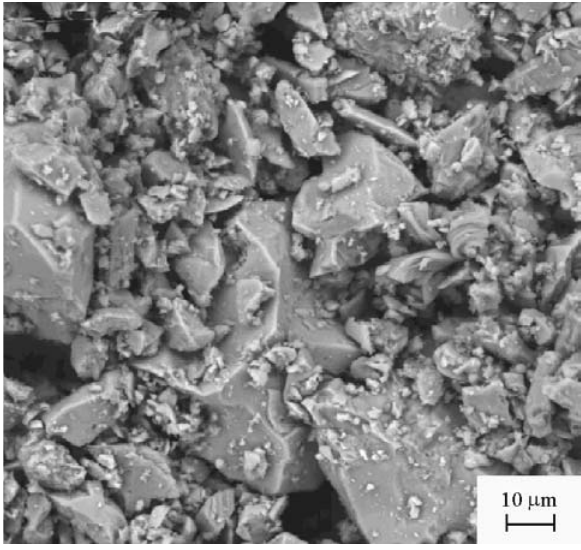
Figure 2. SEM micrograph of the morphology of CPI-S-32 Portland cement powder.